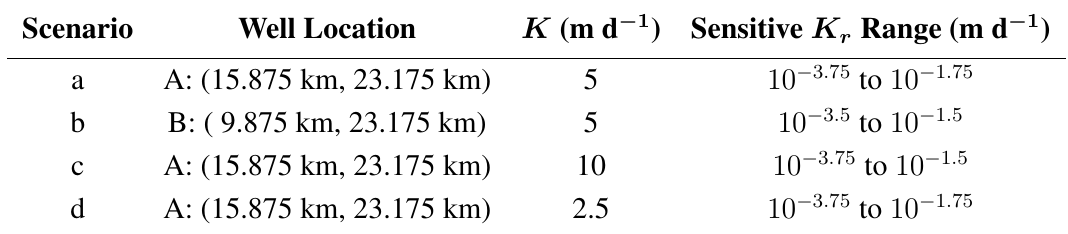
range for each r